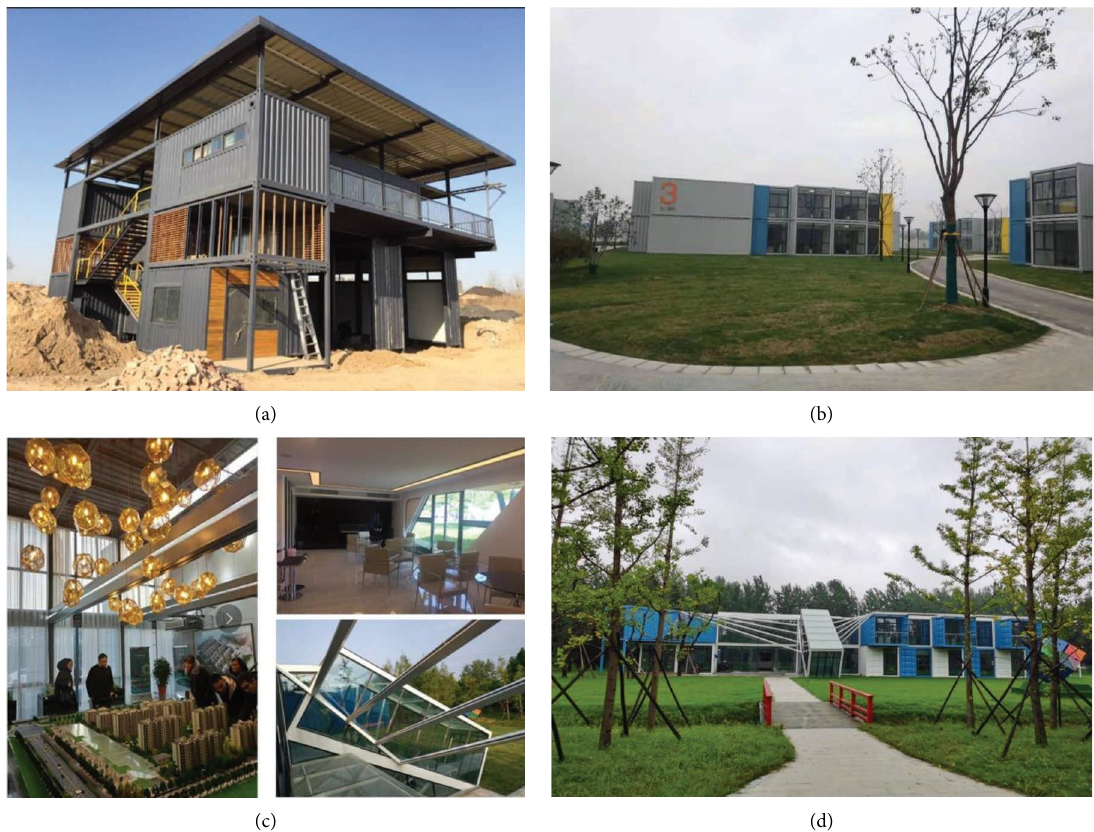
Figure 9: Photo of pilot projects. (a) Container modular fre station under construction. (b) Photo of “Xiangyu” residence in Yangzhou